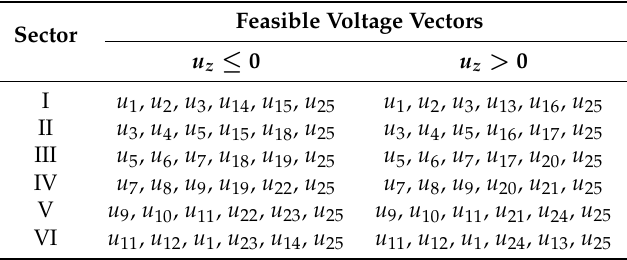
Table 2. Feasible voltage vectors for each sector.